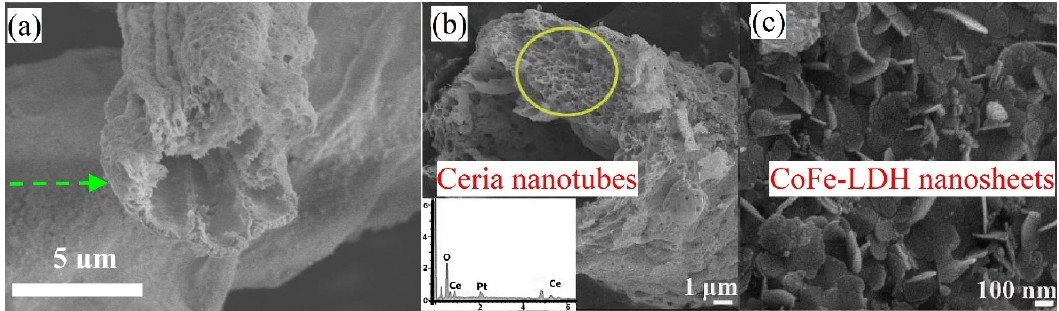
Figure 8. SEM image of ( a ) CeO 2 -ZnO hollow fibers (adapted from [90]); ( b ) kapok fibers templated CeO 2 [100]; ( c ) CoFe-LDH/CeO 2 composite (adapted from [100]). CeO 2 [100]; ( c ) CoFe-LDH / CeO 2 composite (adapted from